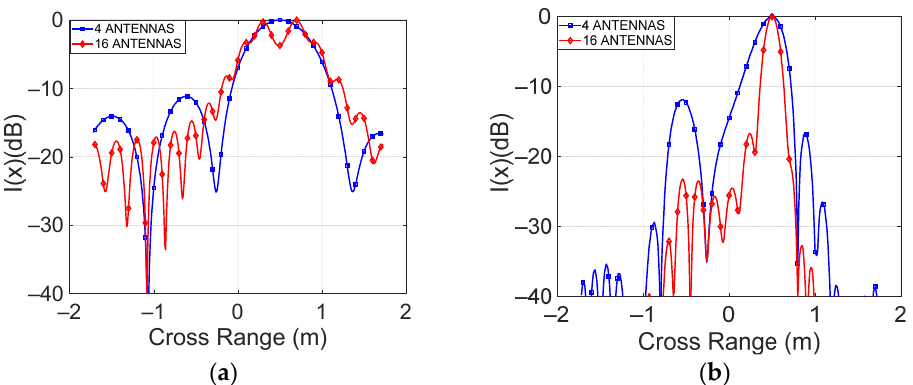
Figure 12. Cross-range cuts of the normalized intensity function for the 4 antennas and 16 antenna cases: ( a ) f 0 = 2 GHz, FBW = 0.1; ( b ) f 0 = 24 GHz, FBW = 0.1.